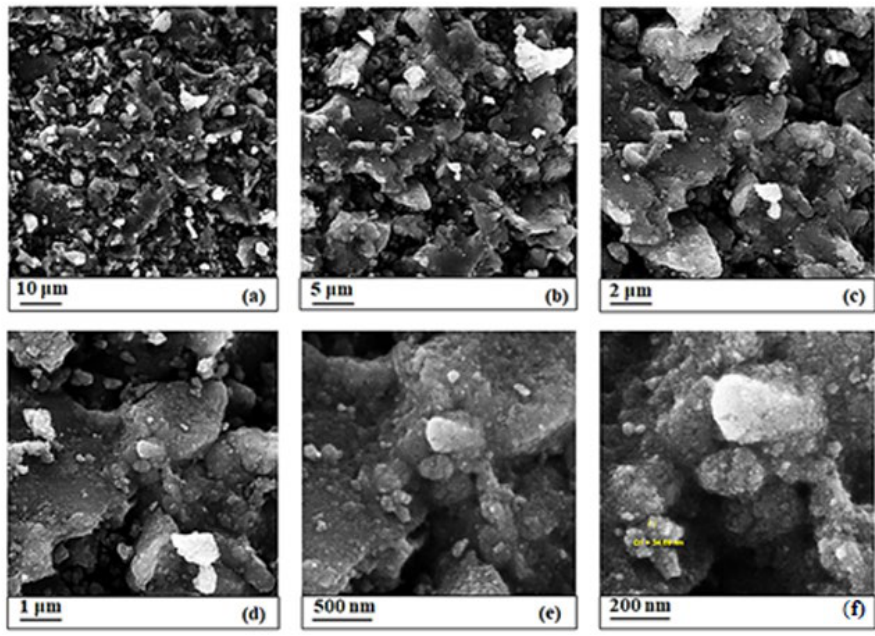
Figure 3. FE − SEM characterization of the synthesized magnetite/Gd 3+ / β − cyclodextrin nanoplatform Figure 3. FE−SEM characterization of the synthesized magnetite/Gd 3+ /β−cyclodextrin nanoplatform with different magnifications 10µm (a), 5µm(b), 2µm (c), 1µm(d), 500nm (e), and 200nm (f). with different magnifications 10 µ m ( a ), 5 µ m ( b ), 2 µ m ( c ), 1 µ m ( d ), 500 nm ( e ), and 200 nm ( f